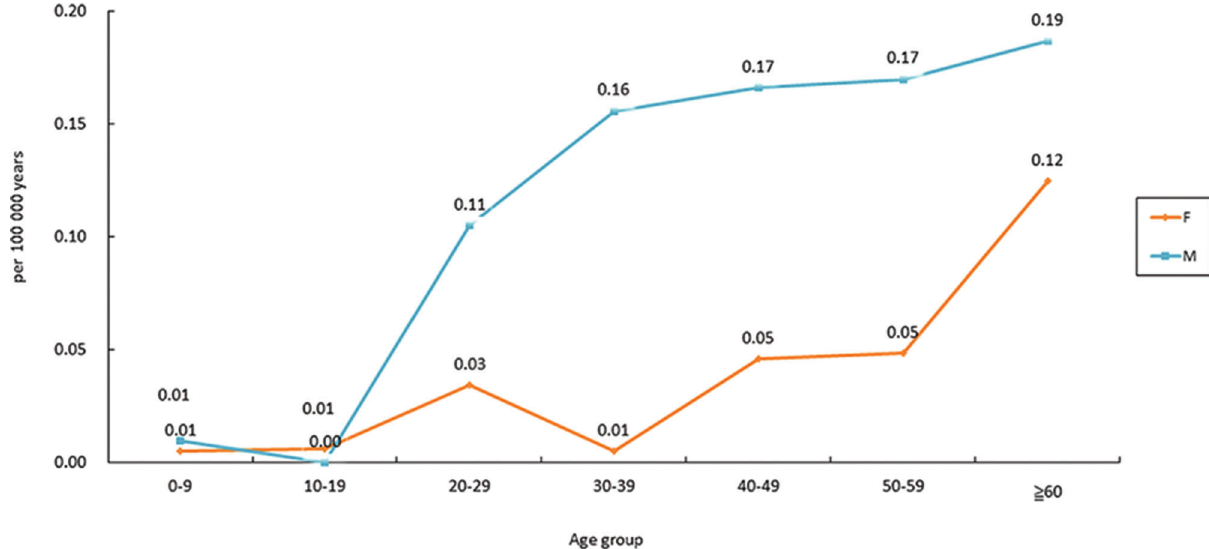
Figure 1 - Age-specific incidence of thromboangiitis obliterans in Taiwan from 2002 to 2011.